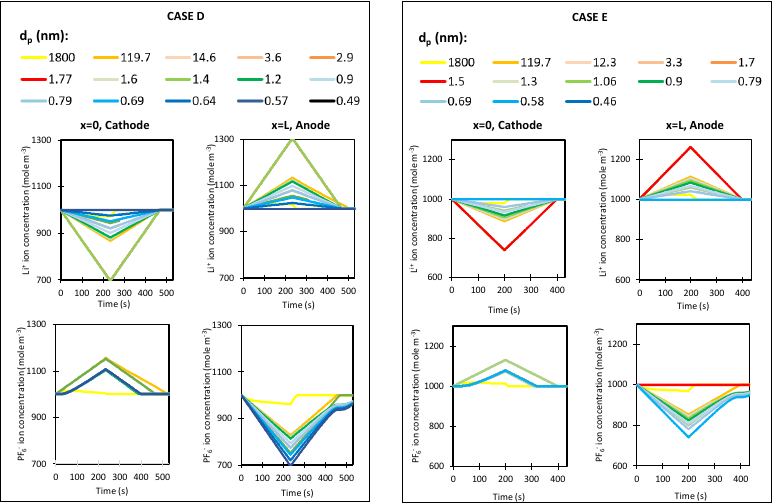
Figure 8. Predicted ion concentration profiles against time at x = 0 (cathode/current collector) and x = L (anode/current collector) for EDLC with electrolyte 1 M LiPF 6 /EC-EMC and: Case D: AC coating electrodes and Case E: ACF fabric electrodes.